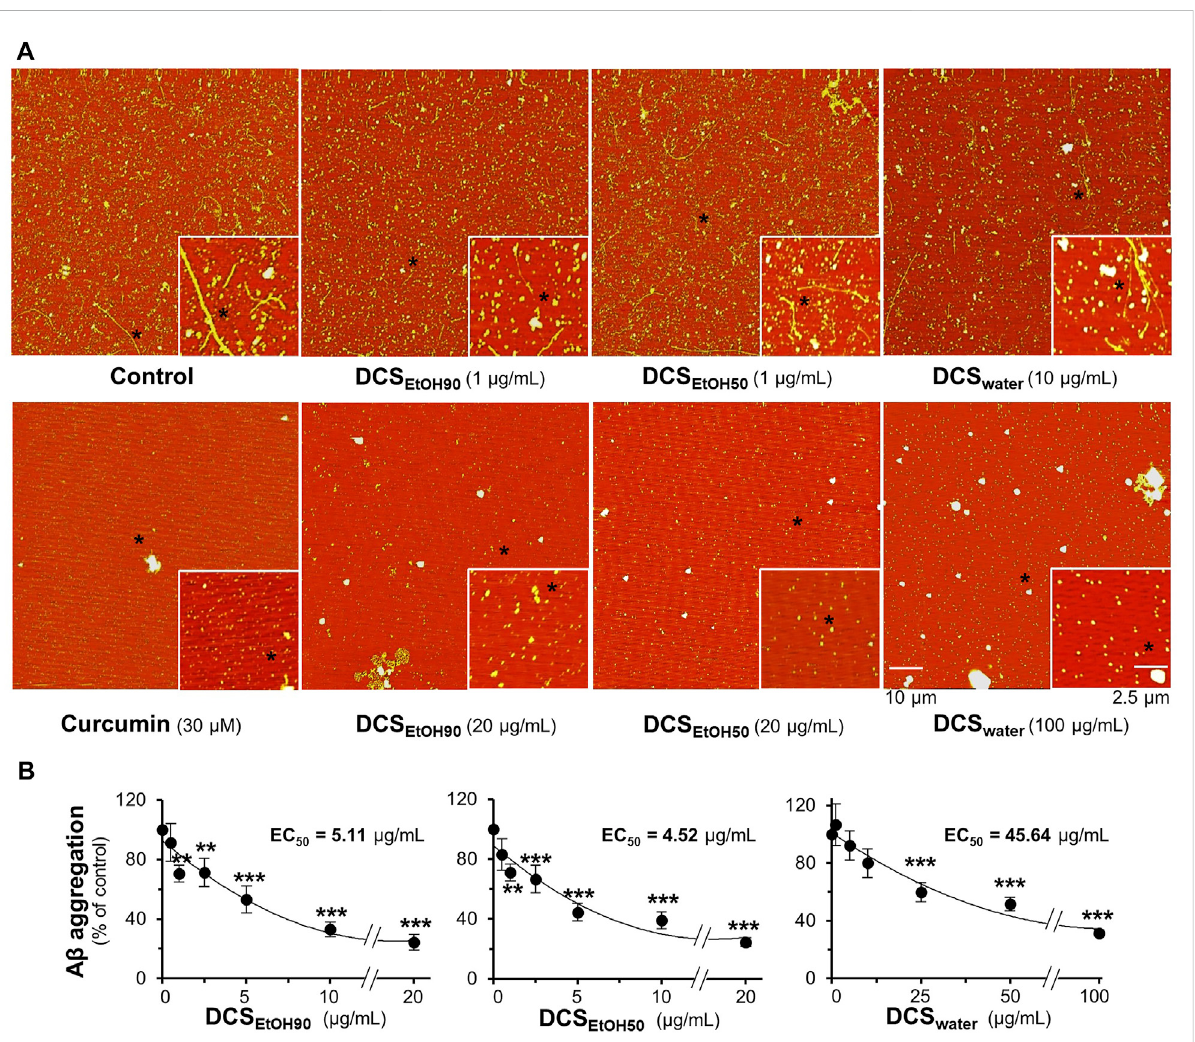
FIGURE 3 D. cochinchinensis stemwood extracts inhibit the formation of A β